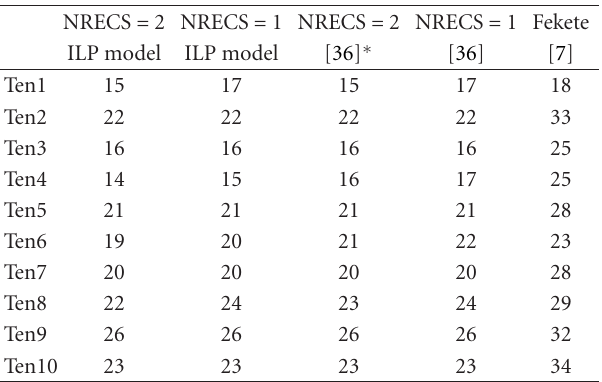
Table 2: ILP results comparison.